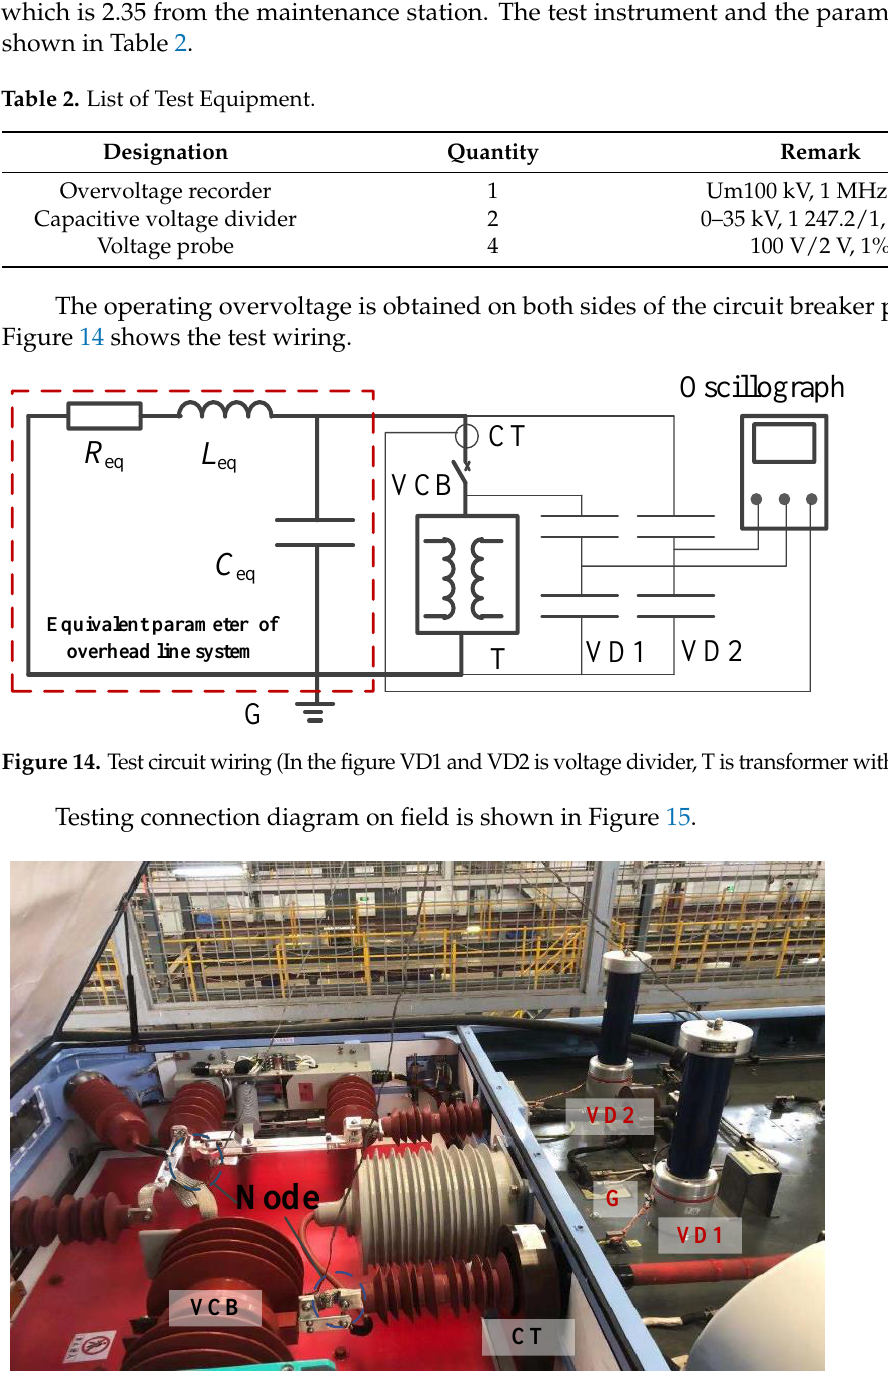
Figure 15. Testing connection diagram on field.